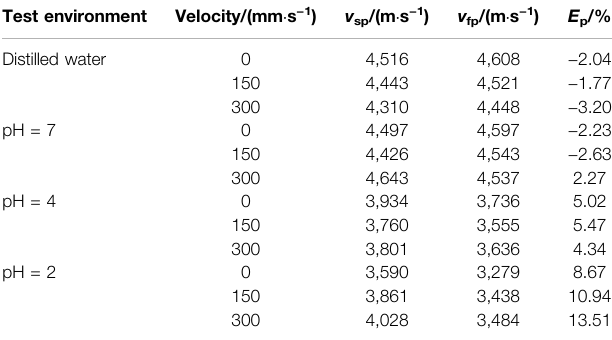
TABLE 2 | Variation in elastic longitudinal wave velocity of granite by different hydro-chemical solutions. Test environment